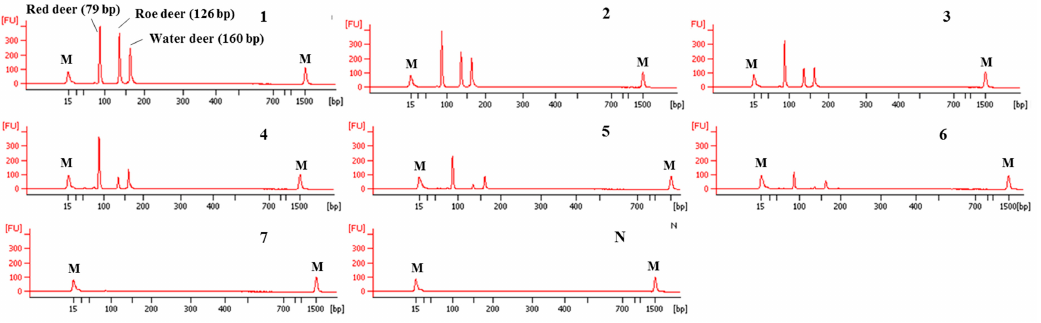
Figure 4. Electropherograms of sensitivity results of the multiplex PCR assay. FU: fluorescence, M: alignment marker, lanes 1–7: 1.0 × 10 1 , 10 0 , 10 − 1 , 10 − 2 , 10 − 3 , 10 − 4 , and 10 − 5 ng of three target species, and lane N: non-template.